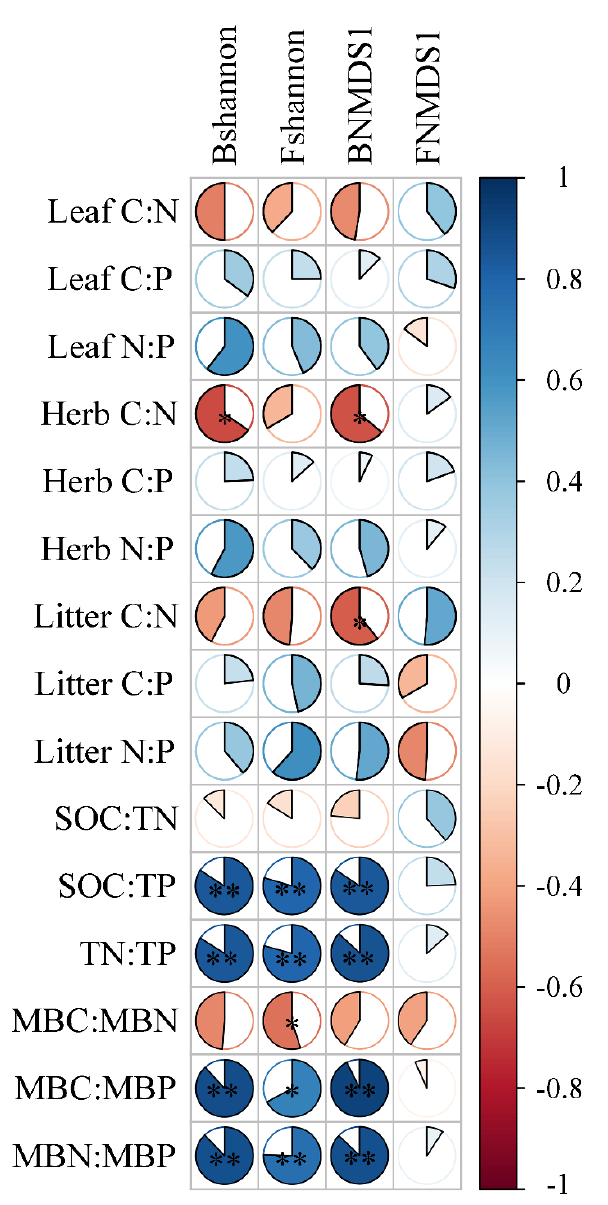
Figure 5. Spearman’s rank correlation coefficient between the alpha (Shannon Index) and beta diversities (NMDS1) of microbial communities, the C:N:P stoichiometric ratio in plant, soil, and microbial biomass. * & ** Significant at p < 0.05 and p < 0.01, respectively.